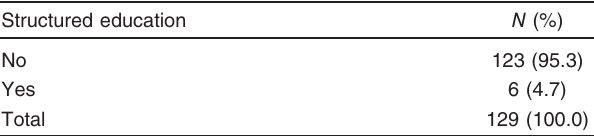
Table 9 Distribution of doctors as regards having structured educational programs to chronic obstructive pulmonary disease patients in service